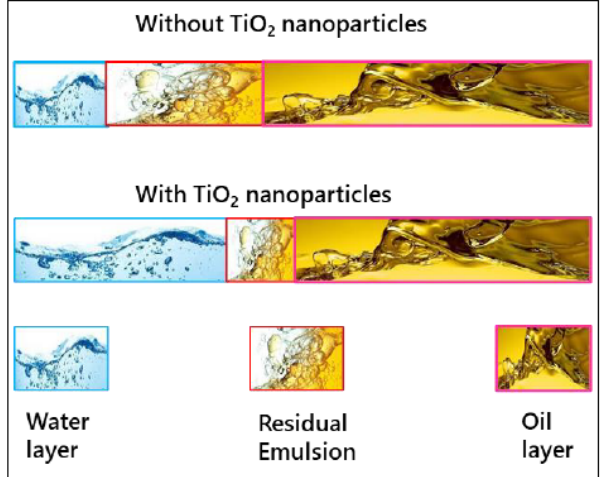
Figure 6. Schematic diagram of the de-emulsification of ASP-produced emulsion without TiO 2 nanoparticles and with TiO 2 nanoparticles and water, rag, and oil layer